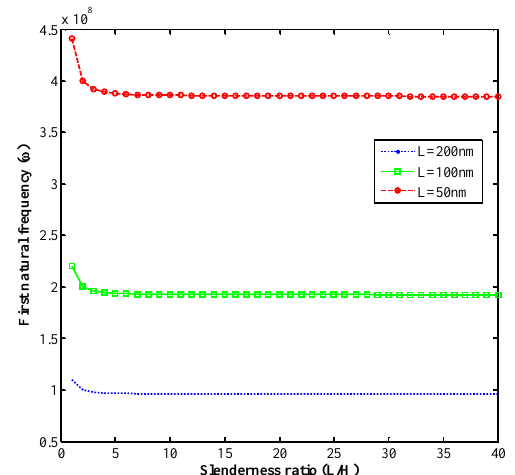
Fig. 1. The influence of material length scale parameter on the first natural frequency.